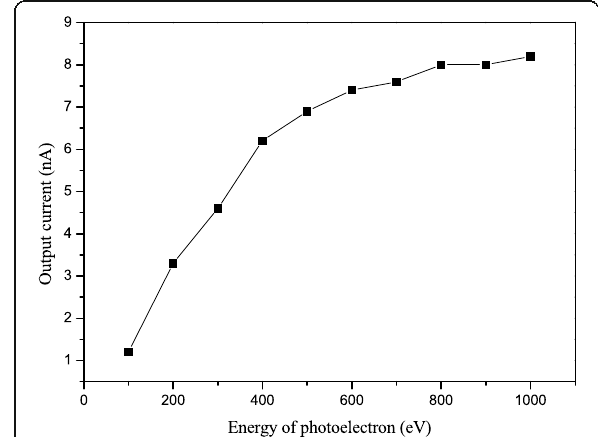
Fig. 3 Bias voltage between cathode and MCPin as function of MCP output